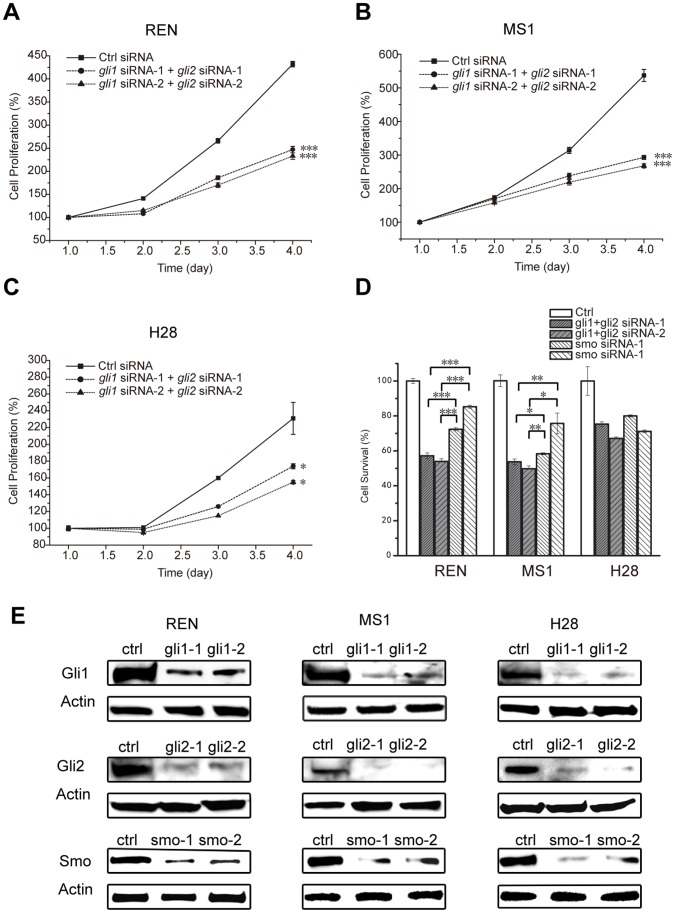
Suppression of Gli1 and Gli2 by siRNA Inhibited Cell Proliferation. A-C, Cell proliferation was significantly reduced by double siRNA treatment targeting gli1 and gli2 in three MPM cell lines. Two sets of independent siRNA were applied in each assay. MTS assay was used to measure cell proliferation at 72 hours after siRNA transfection. D, Comparison of Smo and Gli inhibition at suppressing cell proliferation at 72 hours after siRNA transfection. Two-sided student’s t-test was performed between control siRNA and gli siRNA (A-C), between gli siRNA and smo siRNA in REN and MS1 (D). A p value <0.05 was indicated as *, <0.01 as **, and <0.001 as ***. E, The efficiency of siRNA was monitored by western blot at 72 hours after transfection in REN MS1 H28. Each gene was knocked down with two independent siRNAs.